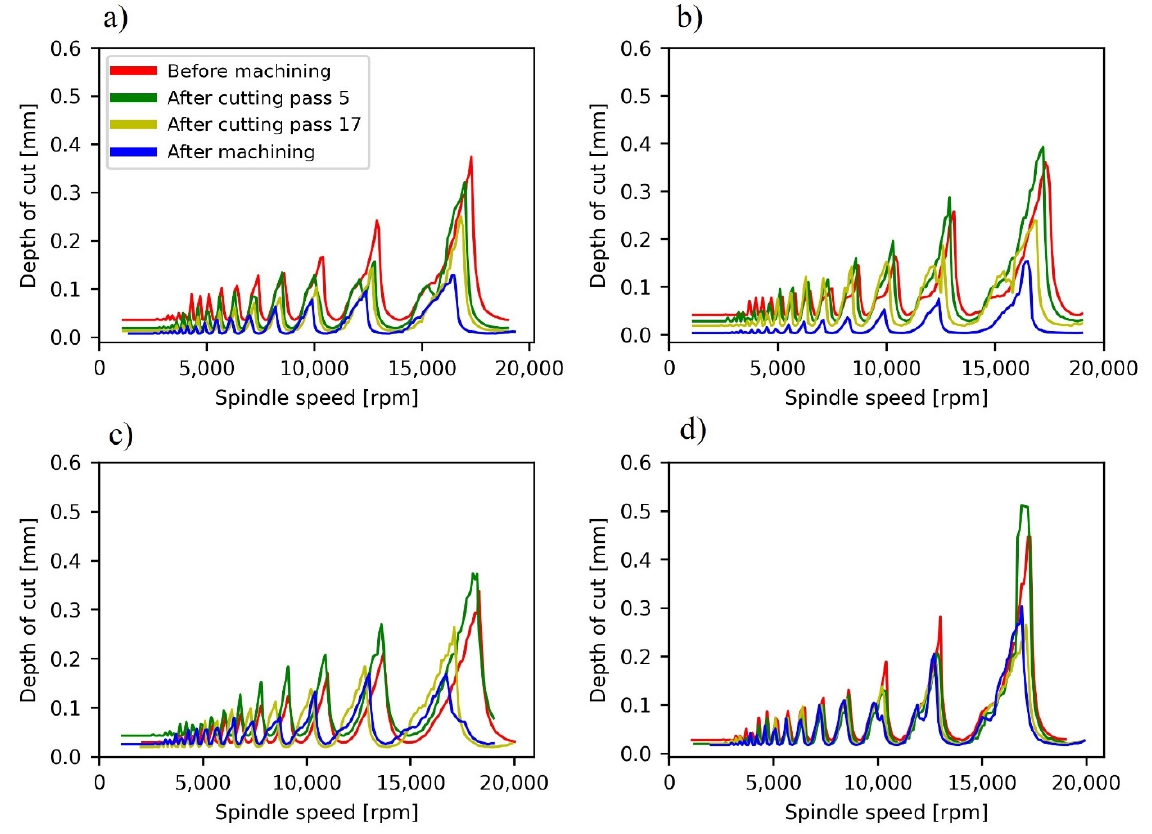
Figure 5. Stability lobe diagrams before, during and after pocket milling. ( a ) TP10. ( b ) TP08. ( c ) TP04. ( d ) TP02.